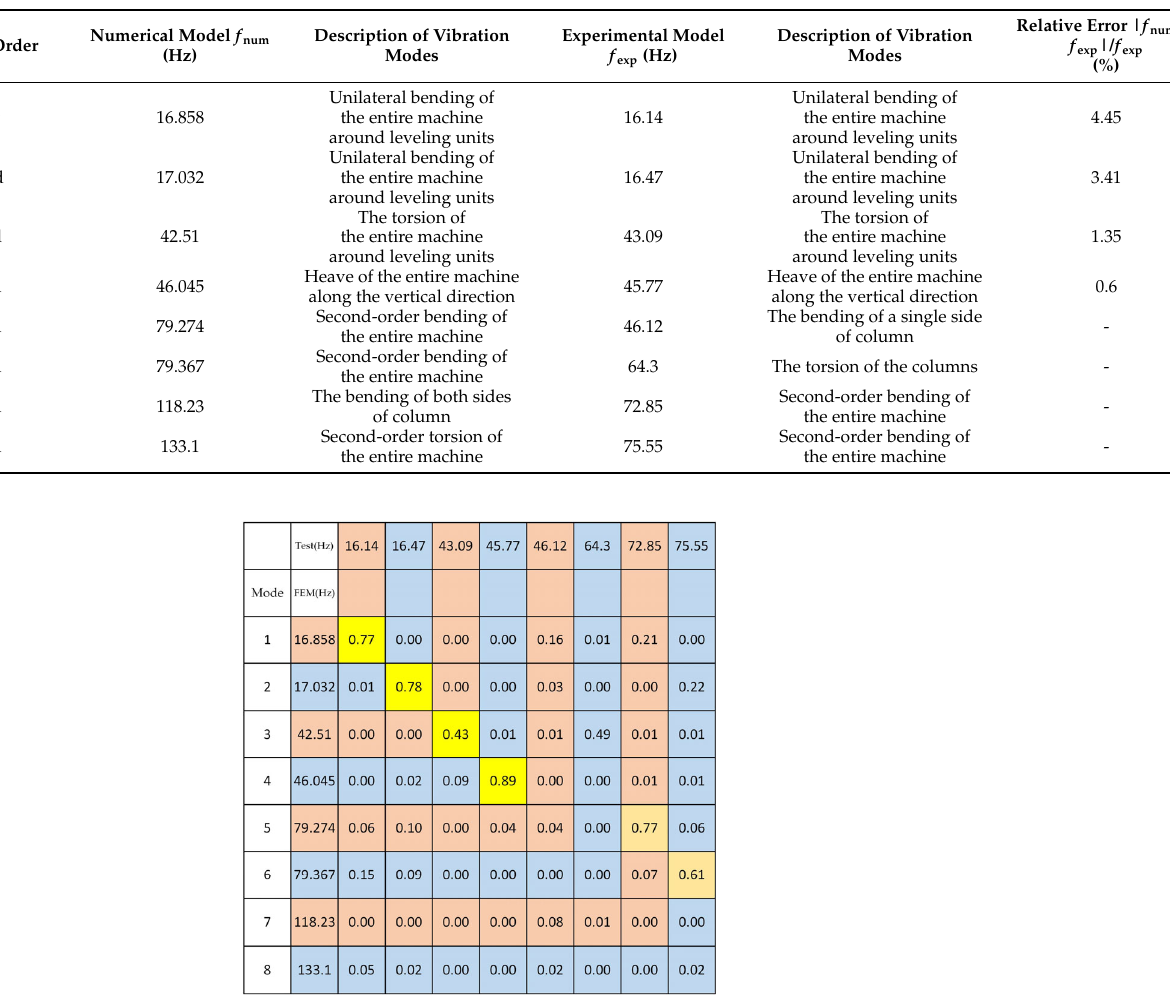
Table 6. Comparison of numerical simulation results and experimental data.